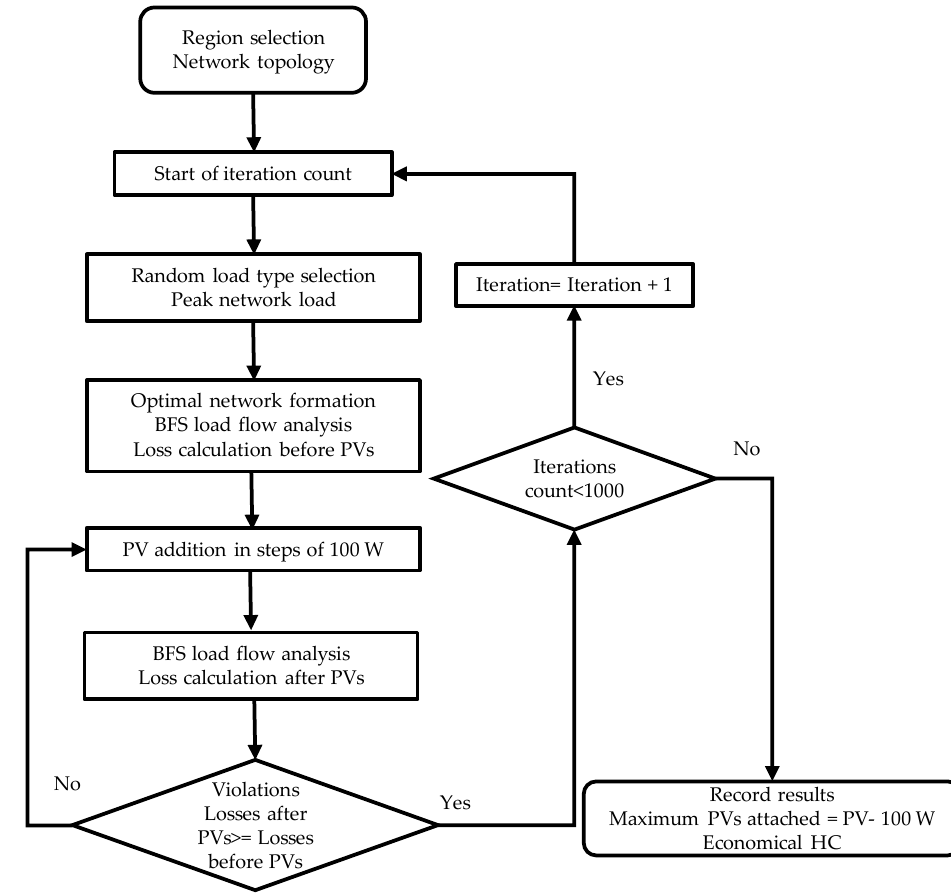
Figure 7. The assessment methodology for economical hosting capacity.